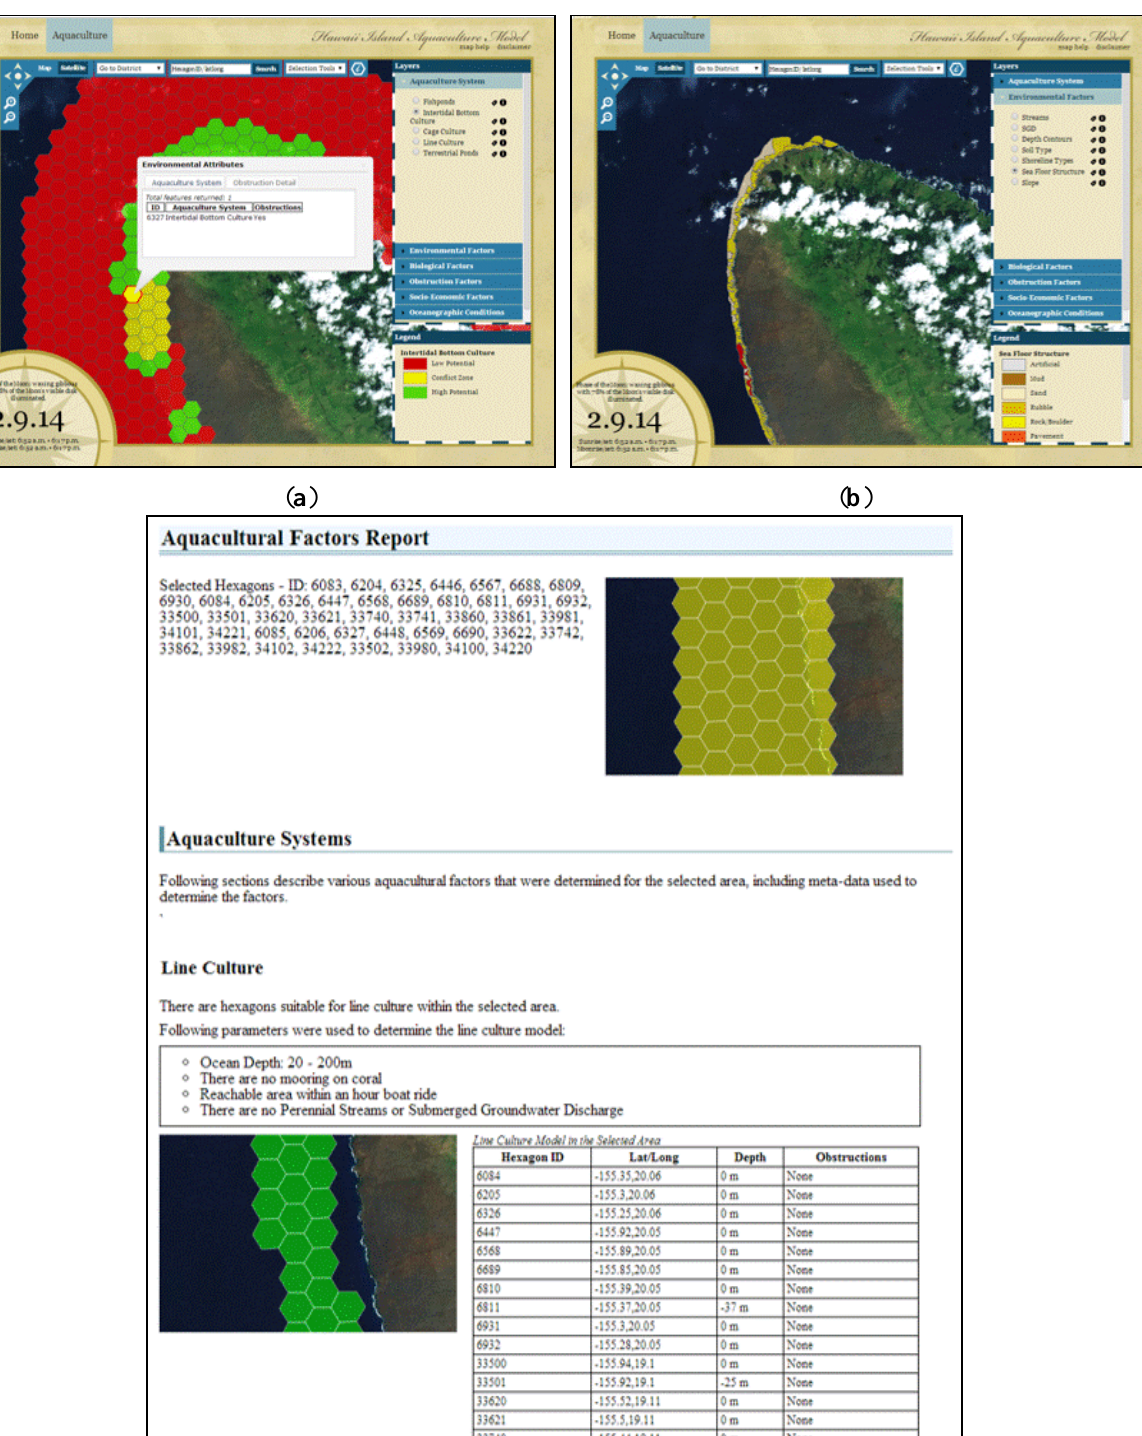
Figure 3. Sample screen shots from the web interface. ( a ) Summary of attributes for selected hexagons with legend and layer options visible on the right; ( b ) Sample aquaculture factors report, pg.1 of 14 summarizing selected hexagon attributes; ( c ) Selection of one feature layer, sea floor structure with legend and layer options visible on the